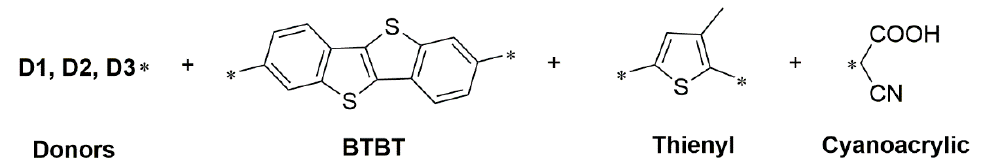
Figure 4. Units to be reacted to prepare the organic dyes.